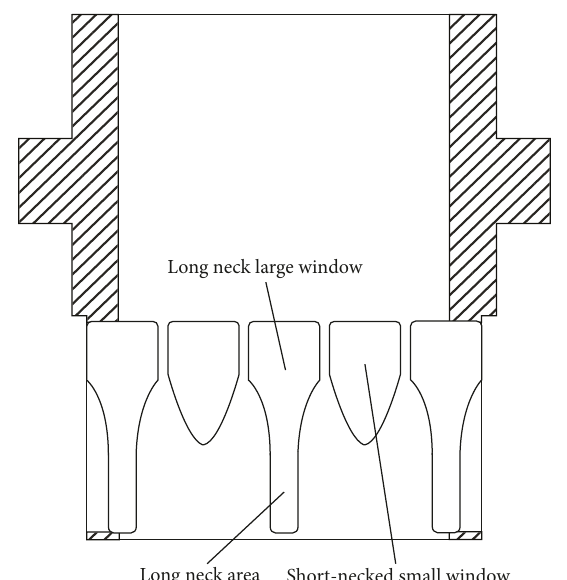
Figure 2: Curved valve cage structure.